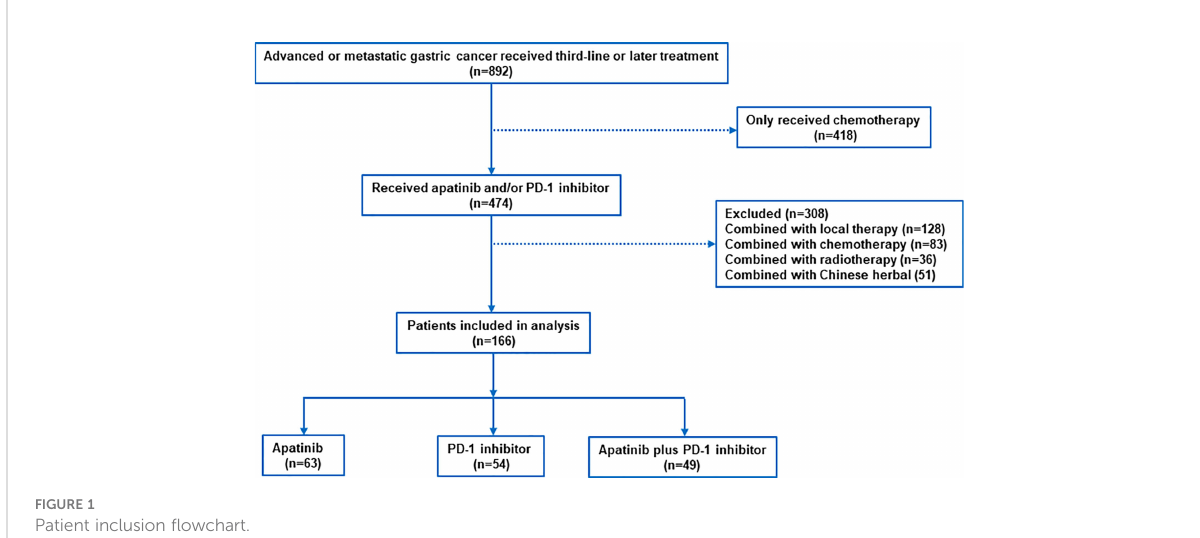
FIGURE 1 Patient inclusion fl